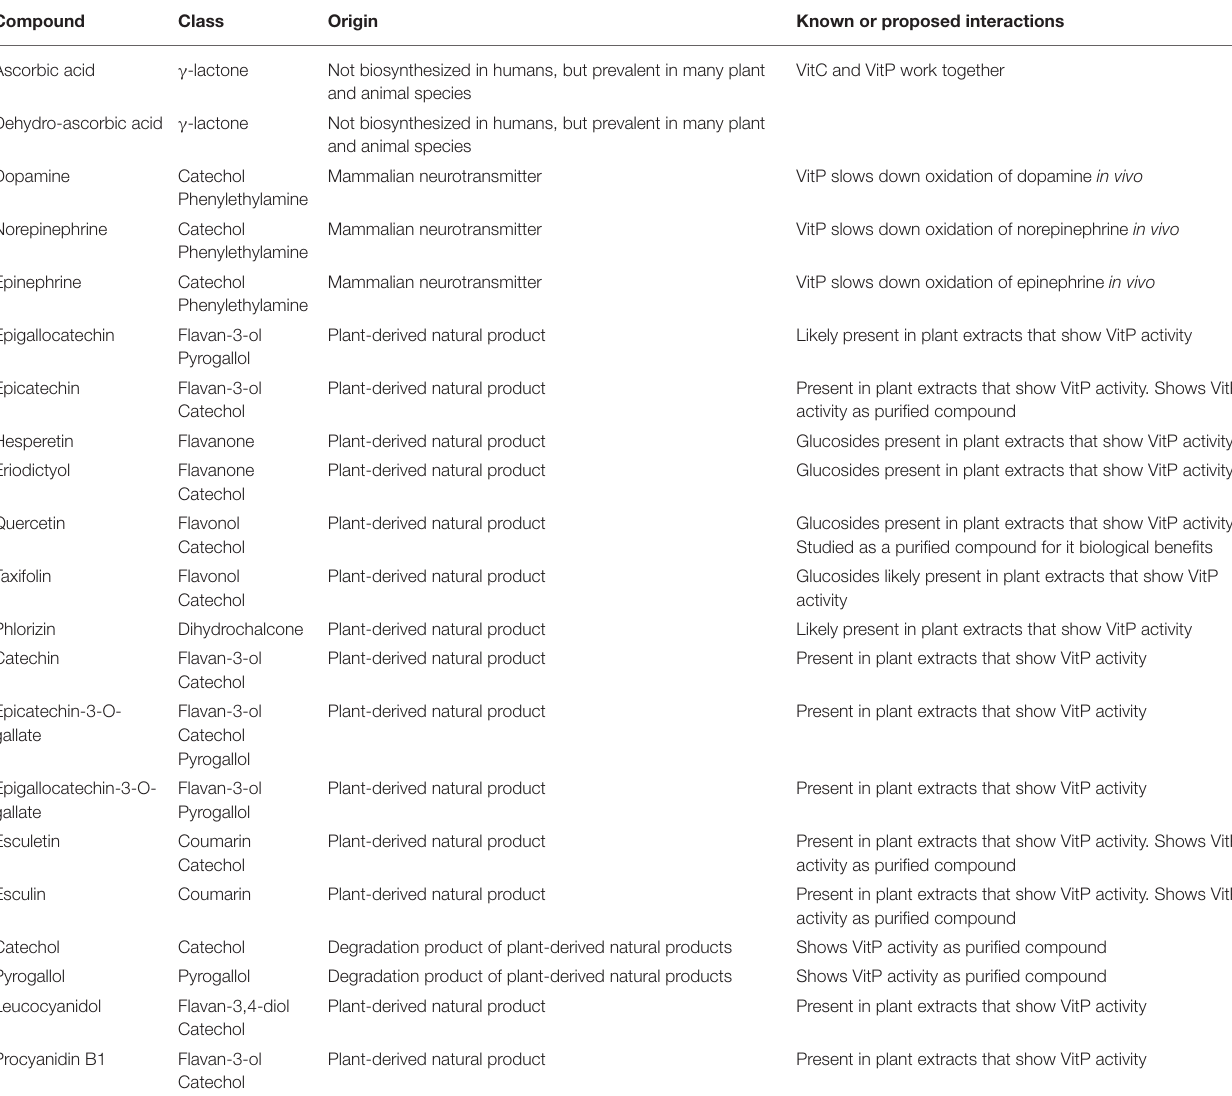
TABLE 2 | Description of the compounds shown in Figure 1 with an emphasis on their role in the vitamin P story.